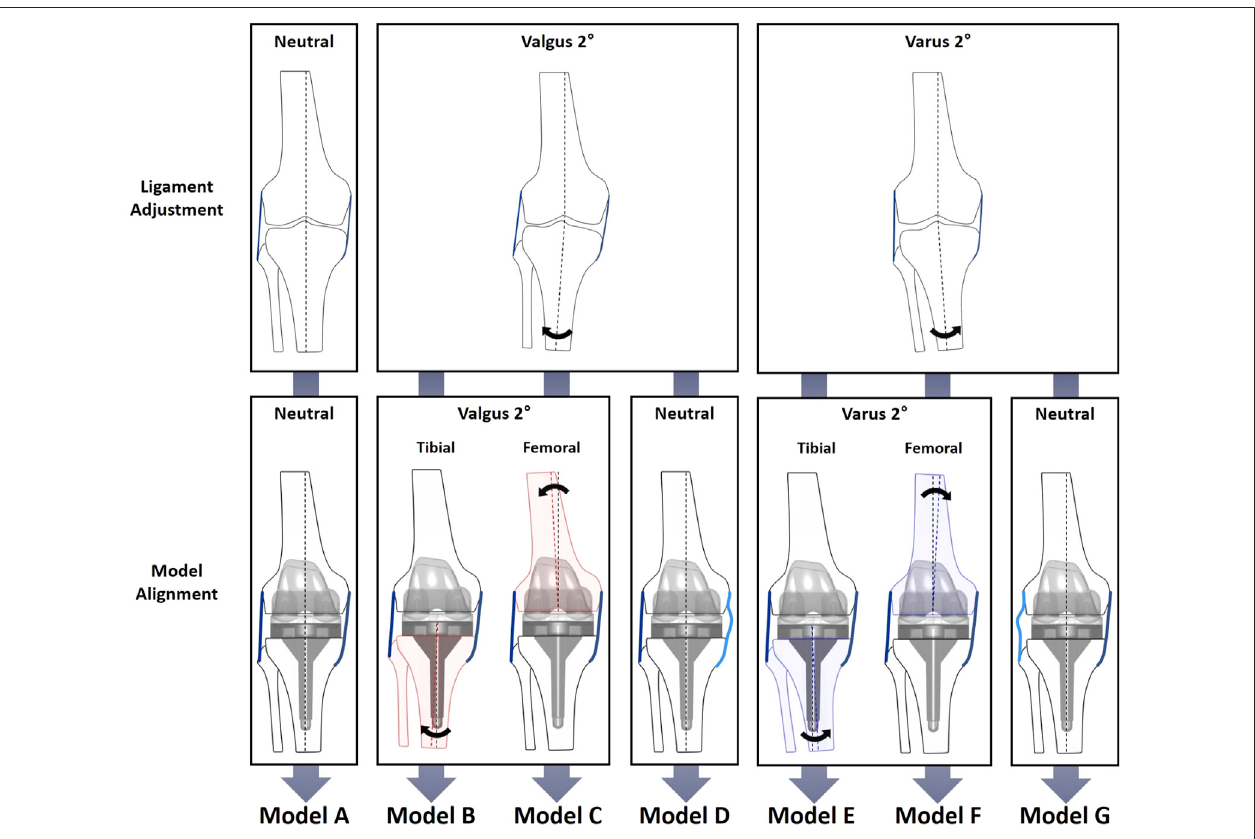
FIGURE 3 | Diagram of varus/valgus, medial/lateral laxity, and tibial/femoral replacement model con fi gurations. The neutral alignment model (model A) was transformed into six cases: the 2 ° tibial valgus (model B) and femoral valgus (model C) alignment models with no laxity; the 2 ° tibial varus (model E) and femoral varus (model F) alignment models with no laxity; and neutral alignment models with 2 ° medial (model D) and lateral (model G) laxity. Medial and lateral laxity in models D and G are illustrated by light blue